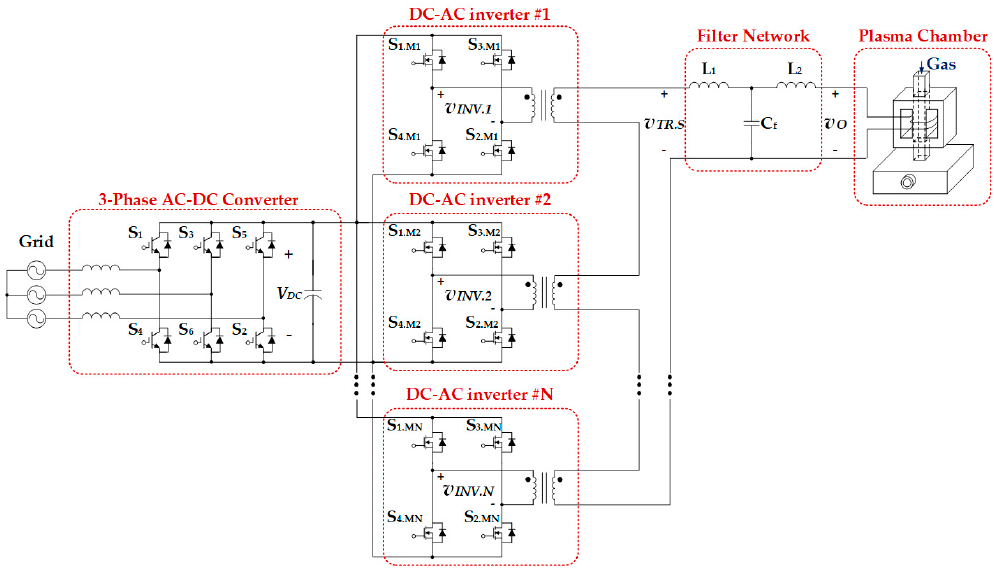
Figure 1. Configuration of the two-stage AC-AC converter for plasma generators.